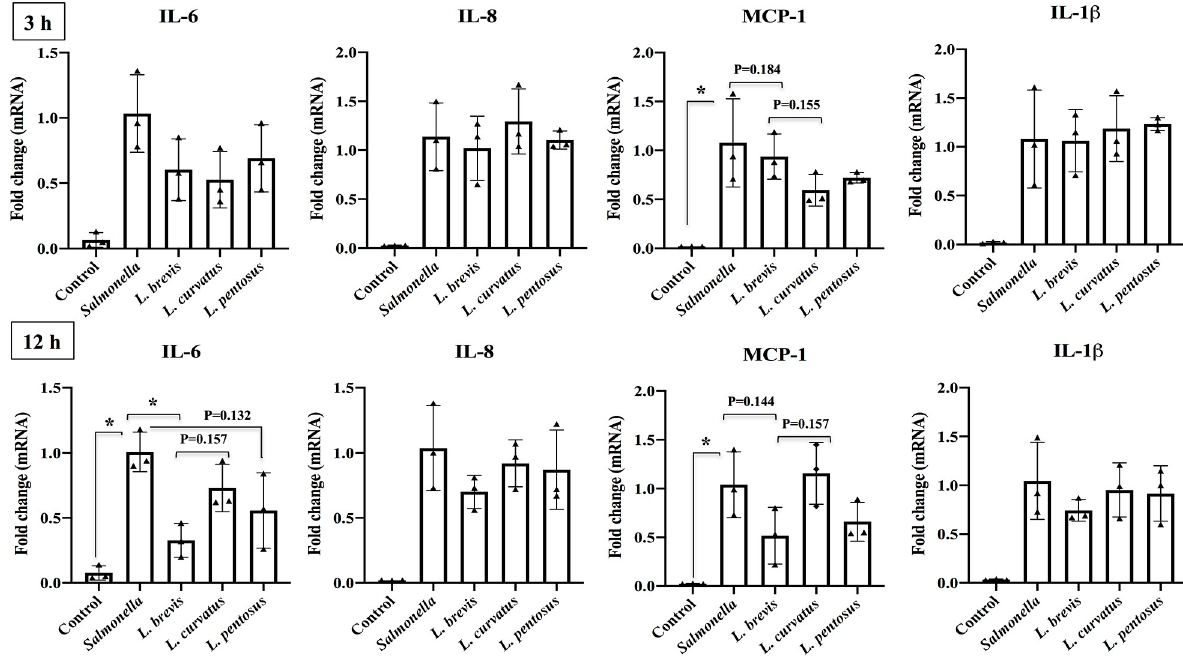
Fig 1. Lactobacillus strains reduce Salmonella induced cytokines expression in IECs. HT-29 cells were pre-stimulated with Lactobacillus strains (5 × 10 7 cells/ml) for 48 h and then post-stimulation with Salmonella for 3 and 12 h. The mRNA level of IL-6, IL-8, MCP-1 and IL-1 β were determined by RT-PCR. HT-29 cells either with medium or Salmonella alone were used as controls. The results represented here is an average values (mean ± S.D) of three independent values. Significant differences between the groups, � p < 0.05.